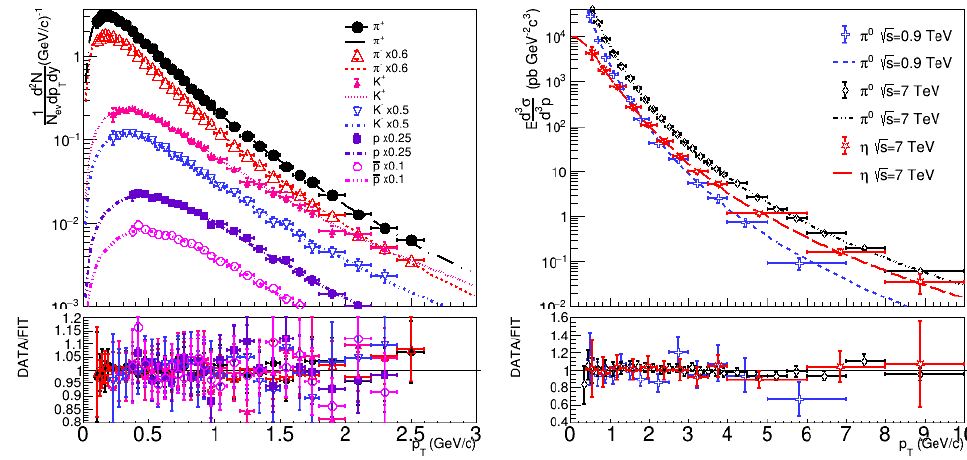
Figure 4. The double-differential transverse momentum distributions, fitted by the Lorentz invariant cross-section (8). The data are from